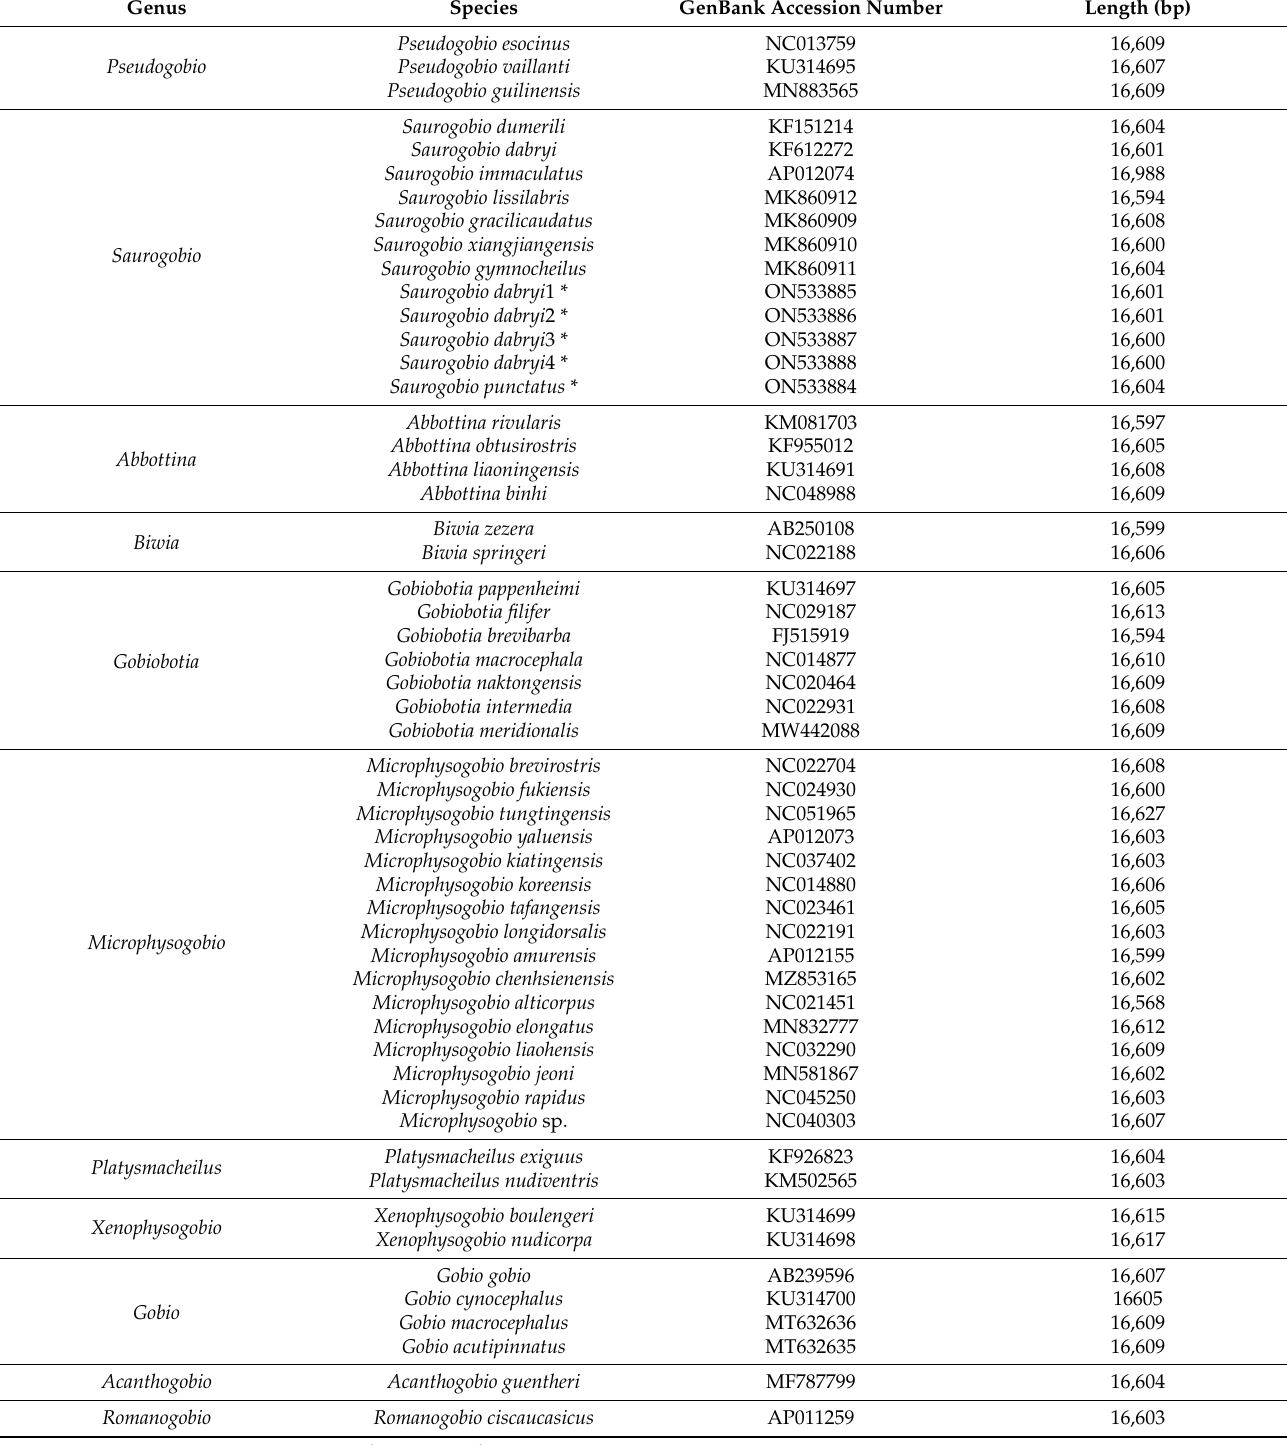
Table 1. The detailed information of species used in the present